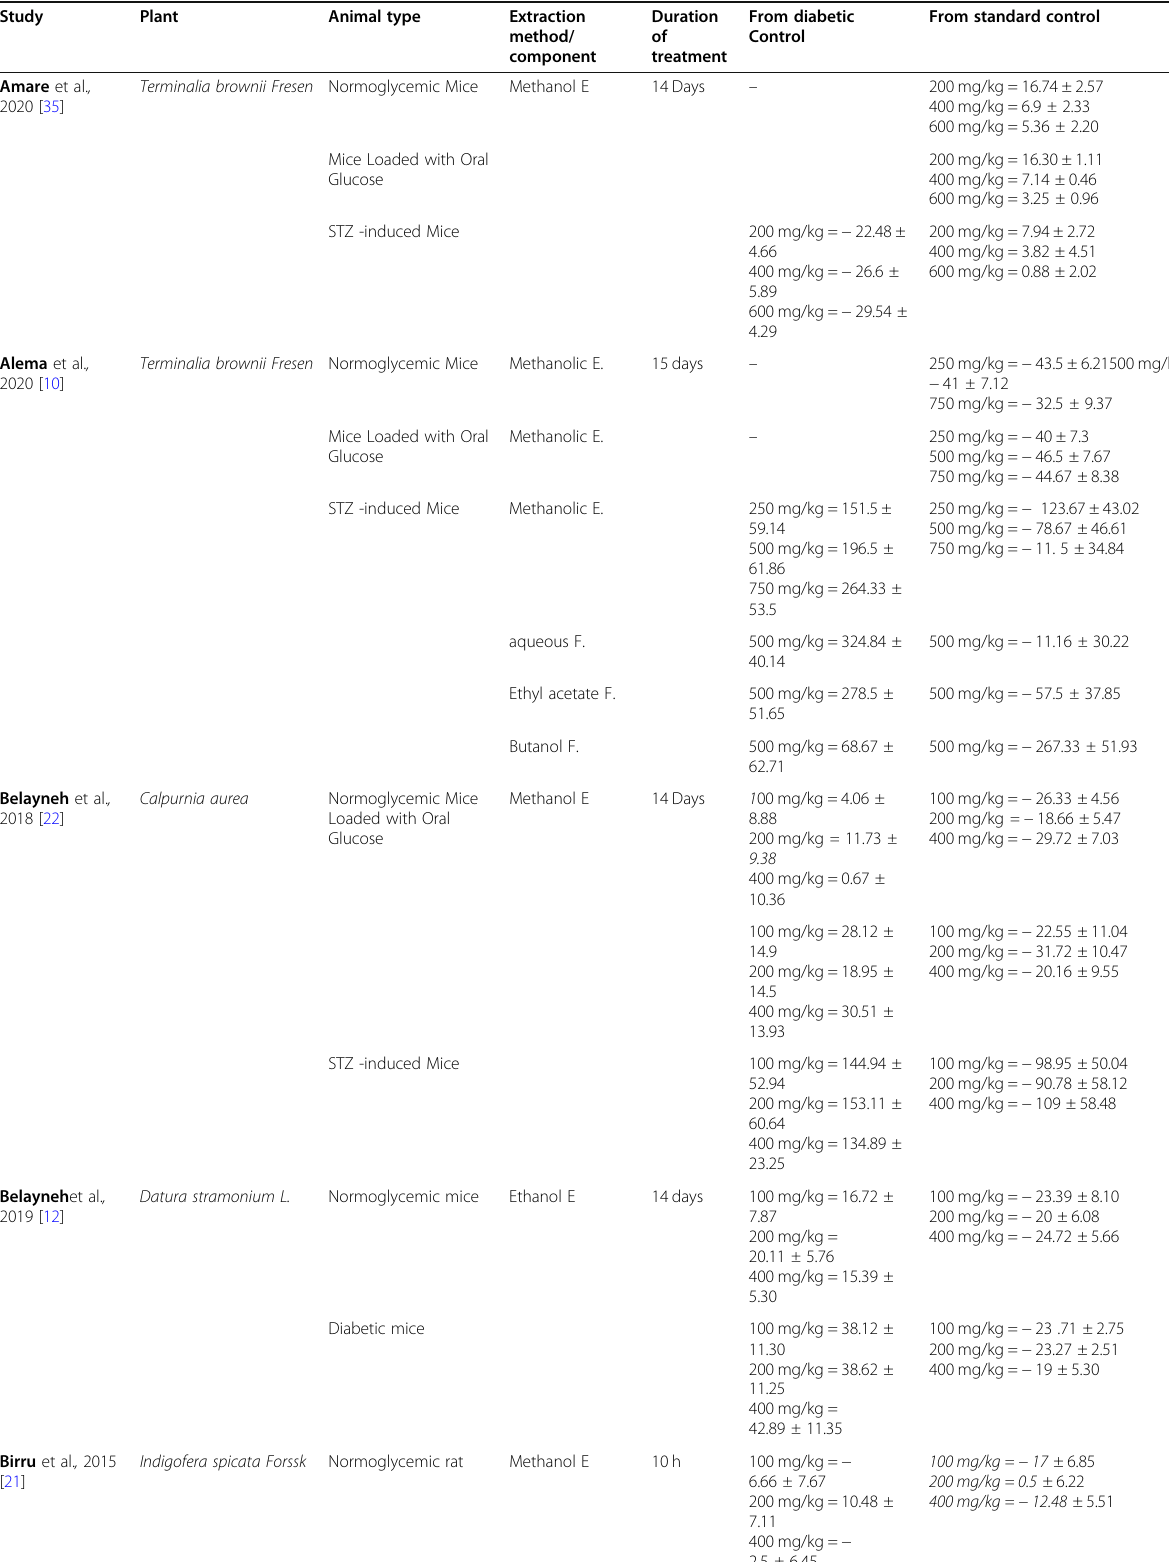
Table 3 In vivo anti-diabetic activity of medicinal plat in